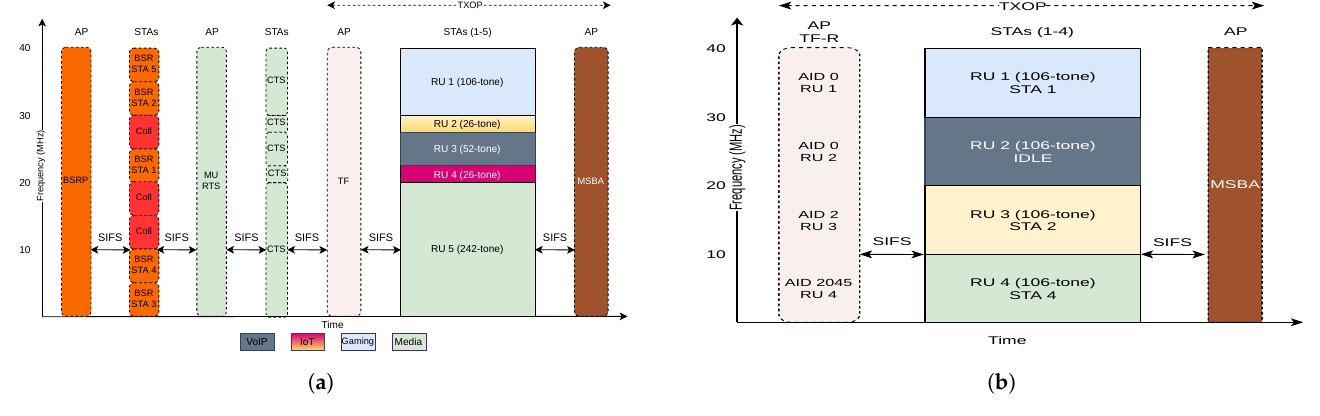
Figure 10. UL MU OFDMA scheduled and random access within a 40 MHz channel. ( a ) UL MU OFDMA scheduled access transmission over different RUs and traffic demands. ( b ) UL OFDMA random access (UORA) transmission over different RUs (stations 1, 2, and 3 have the Association Identifiers (AIDs) 1, 2, and 3, respectively. Station 4 is